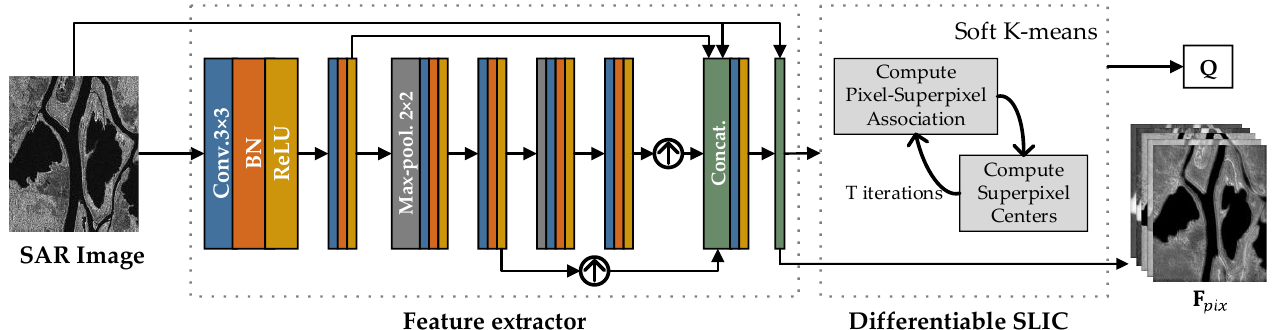
Figure 3. Superpixel sampling networks (SSNs). The SSN consists of a feature extractor and the differentiable SLIC. Input: SAR image; output: the pixel – superpixel associations 𝑸 and high-level feature 𝑭 𝒑𝒊𝒙 from the feature extractor. The arrows in the black circle illustrate upsampling.